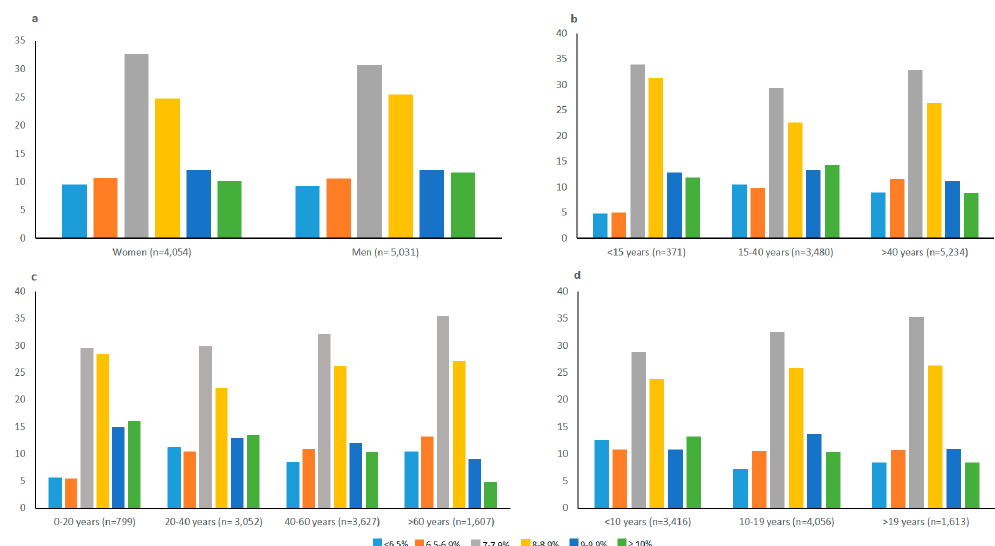
Figure 1. Percentage distribution across HbA1c categories according to sex ( a ), current age ( b , c ) and diabetes duration ( d ). All comparisons between groups were significant ( p < 0.001).